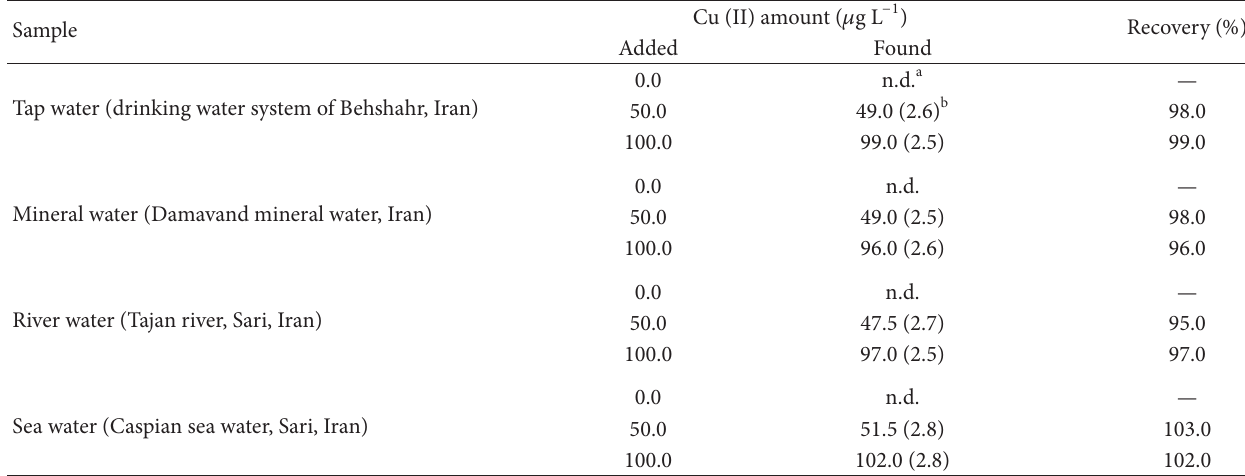
T 2: Determination of copper in water